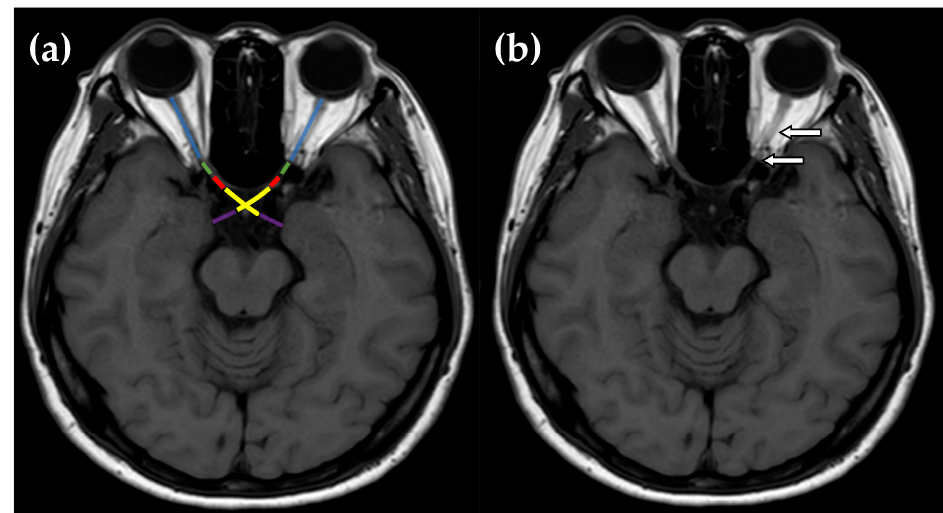
Figure 1. ( a ) Each orbital MRI scan was composed of five segments: orbital optic nerve (blue), intracanalicular optic nerve (green), intracranial optic nerve (red), optic chiasm (yellow), and optic tract (purple). ( b ) MRI T1W scan of a female patient diagnosed with double seronegative optic neuritis showed an orbital and intracanalicular optic nerve enhancement (arrows).